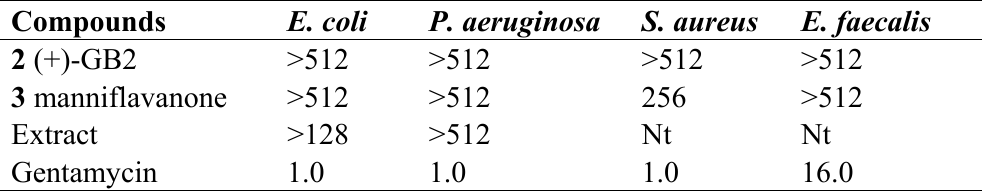
Table 3. Antibacterial activity of G. preussii extract ( μ